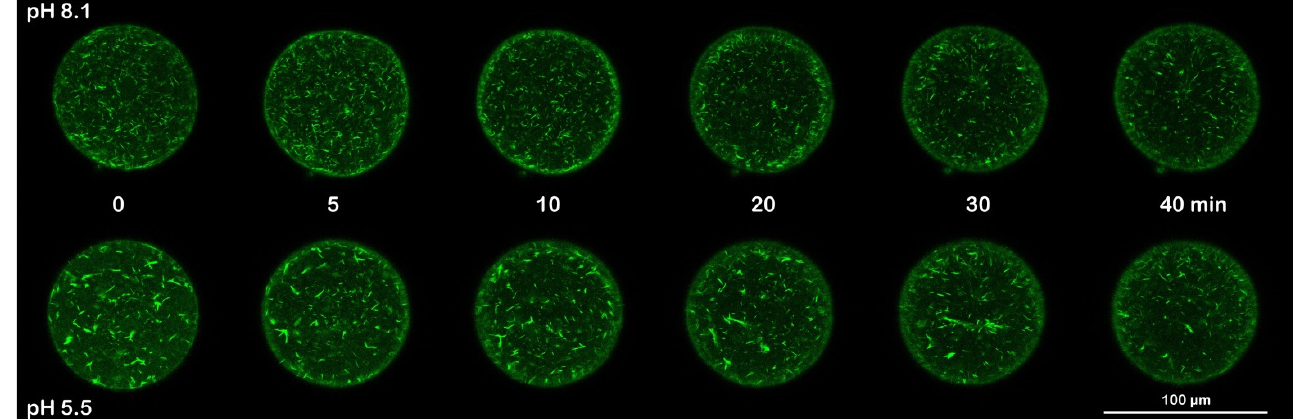
Figure 7. F-actin translocation following fertilization of P. lividus control eggs was inhibited in eggs incubated and inseminated in acidic seawater. P. lividus eggs were microinjected with AlexaFluor 568-Phalloidin and incubated in NSW or acidic seawater for 5 min before insemination. The addition of sperm induced F-actin changes, which were monitored by confocal microscopy at the intervals shown in the images. The moment of insemination was set as time 0. F-actin translocation was evident 20 min after the sperm addition, which coincided with the time of the actin polymerization in the egg cortex visualized by the LifeAct-GFP fusion protein shown in Figure 6.